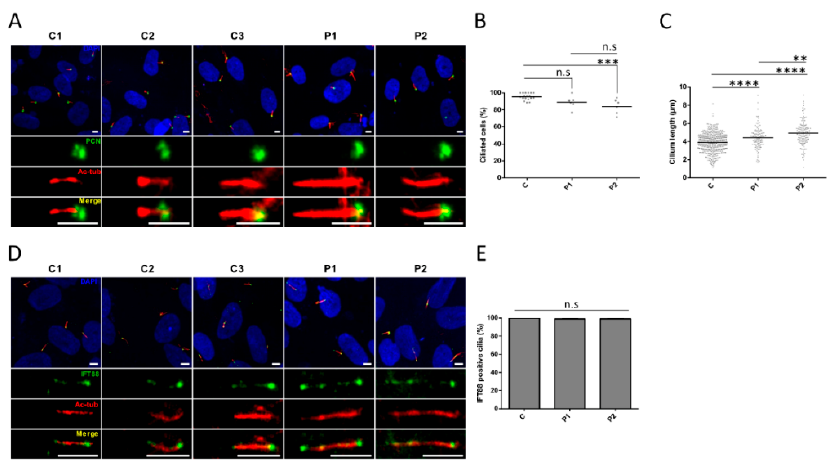
Figure 5. Ciliogenesis and axonemal trafficking. ( A ) Representative images of cilia in the quiescent control (C1–C3) and mutant (P1 and P2) fibroblasts. The cilium axoneme is labeled with acetylated α -tubulin (Ac-tub; red) and the basal body using pericentrin as a marker (PCN; green). Scale bar, 5 µm. ( B ) Percentage of ciliated cells and ( C ) length of cilia axonemes in control and patient fibroblasts. A minimum of 90 ciliated cells were considered for each cell lines. ( D ) Representative images of IFT88 (green) localization along the cilium in quiescent control (C1–C3) and mutant (P1 and P2) fibroblasts. Acetylated α -tubulin (Ac-tub; red) staining was used as a marker of the ciliary axoneme. Scale bar, 5 µm. ( E ) Quantification of IFT88-positive cilia. Bars represent the mean ± SEM ( n ≥ 80 cilia for each group). C regroups the values of C1–C3. ** p ≤ 0.01, *** p ≤ 0.001, **** p ≤ 0.0001, n.s = not significant.